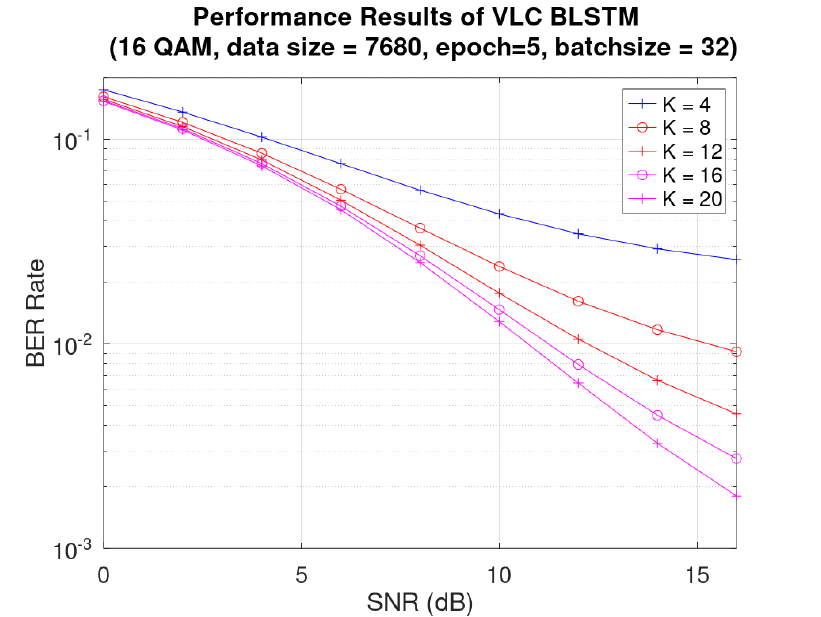
Figure 11. BER performances with various Rician fading factors, 16 QAM for white